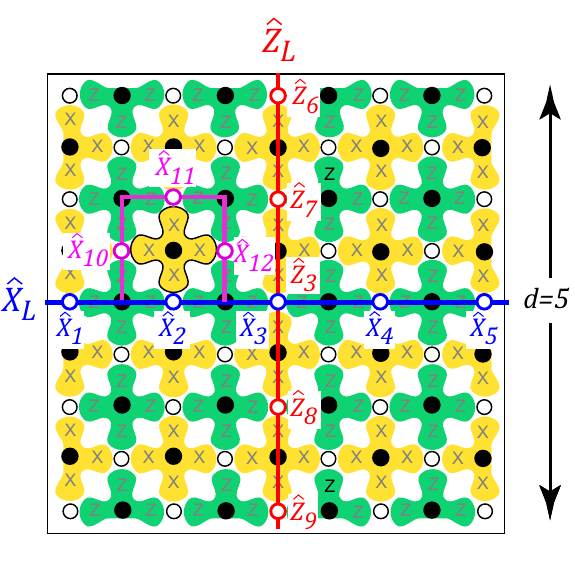
Figure 21: A square 2D array of data qubits, with X boundaries on the left and right, and Z boundaries on the top and bottom. The array has 41 data qubits, but only 40 X X X X and ZZZZ stabilizers. A product chain X and commutes with all the array stabilizers . The product chain Z